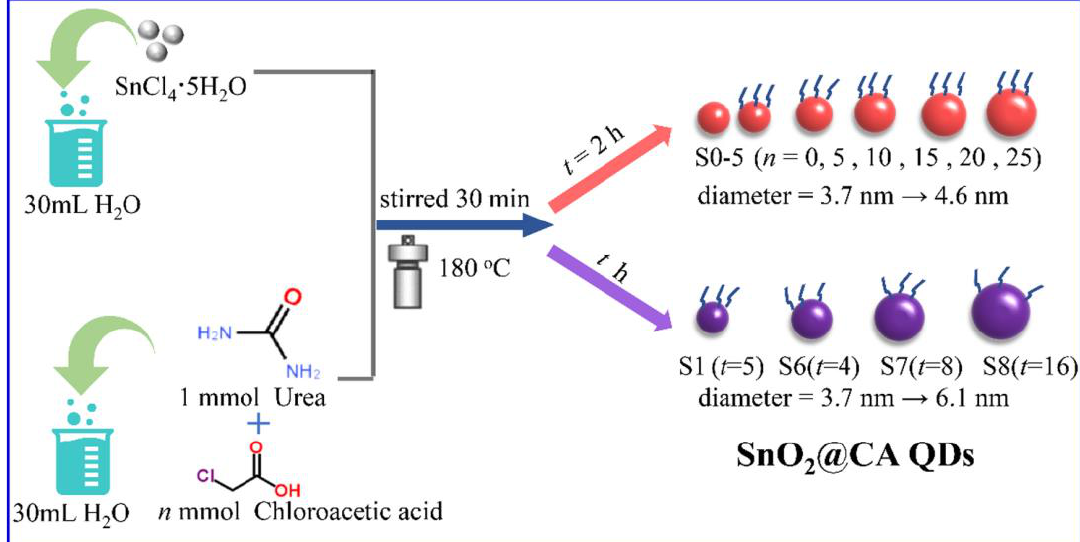
Figure 1. Diagrammatic representation of the SnO 2 QD synthesis process [34], Copyright 2021, Elsevier.